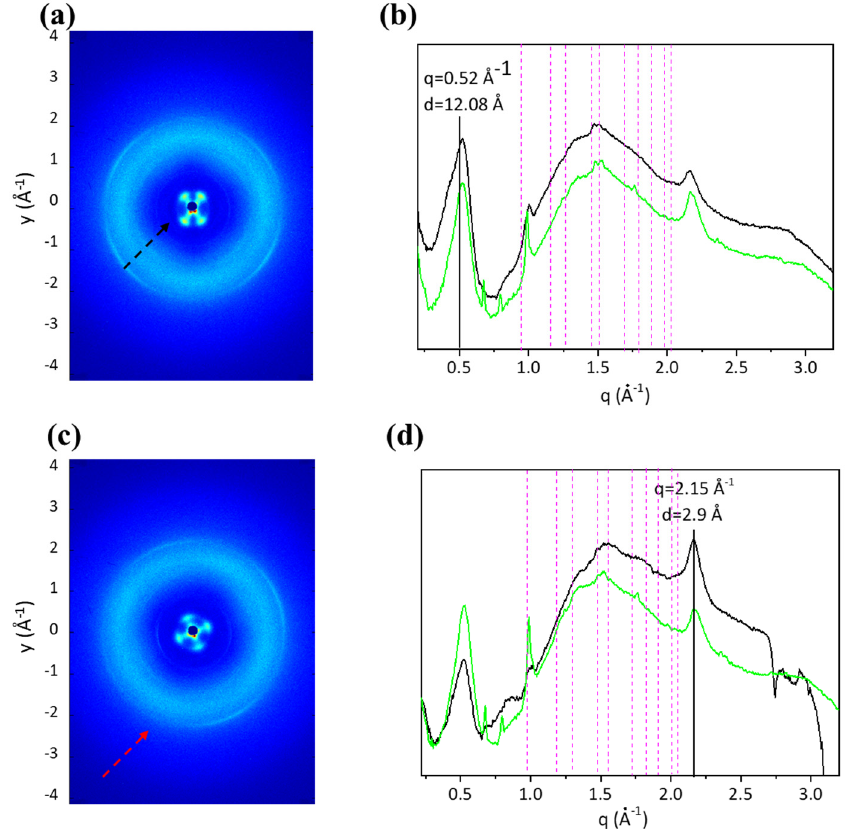
Figure 6. In the 2D diffraction patterns of BT ( a ) and ST ( c ) the equatorial and meridional signals are shown by black and red arrows, respectively. The radial integration along the equatorial ( b ) and meridional ( d ) direction for both ST (green profile) and BT (black profile) are shown. Magenta vertical dotted bars refer to Ultralene ® sachet diffraction.